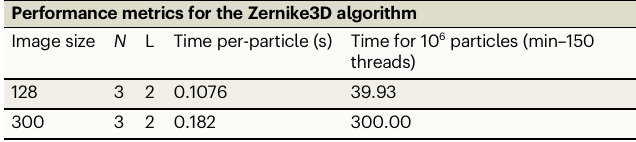
Table 1 | Execution times for the Zernike3D algorithm Performance metrics for the Zernike3D algorithm